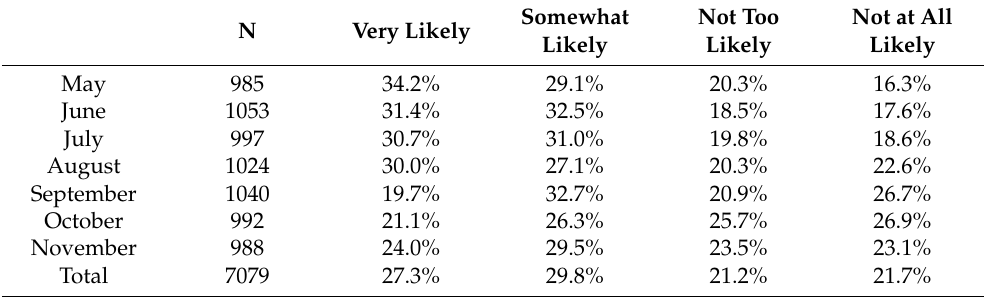
Table 2. Likelihood of Getting an FDA Approved COVID-19 Vaccine as Soon as It is Available. Weighted. Missing values are excluded. Very